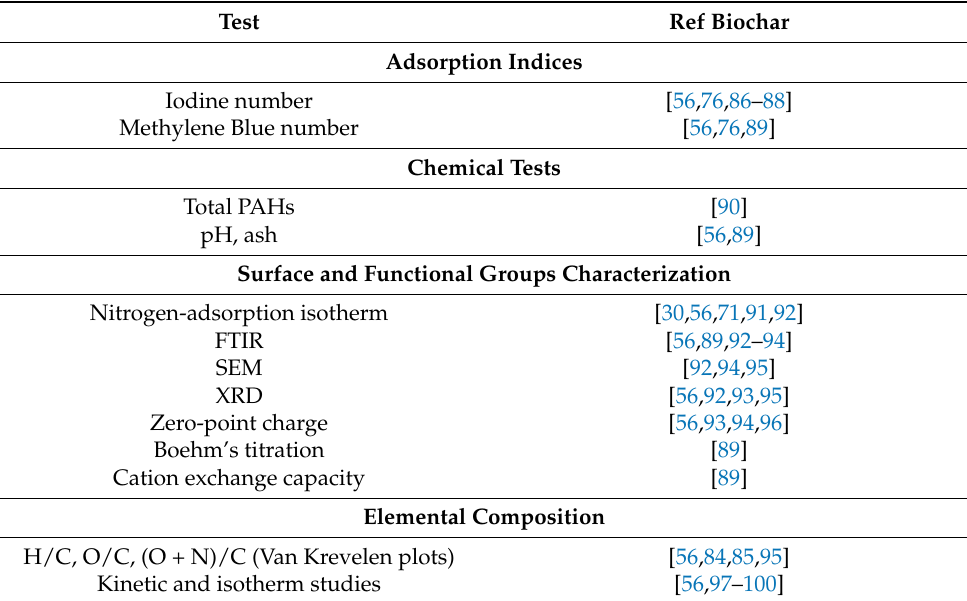
Table 2. Main characterization methods employed for biochar according to the recent